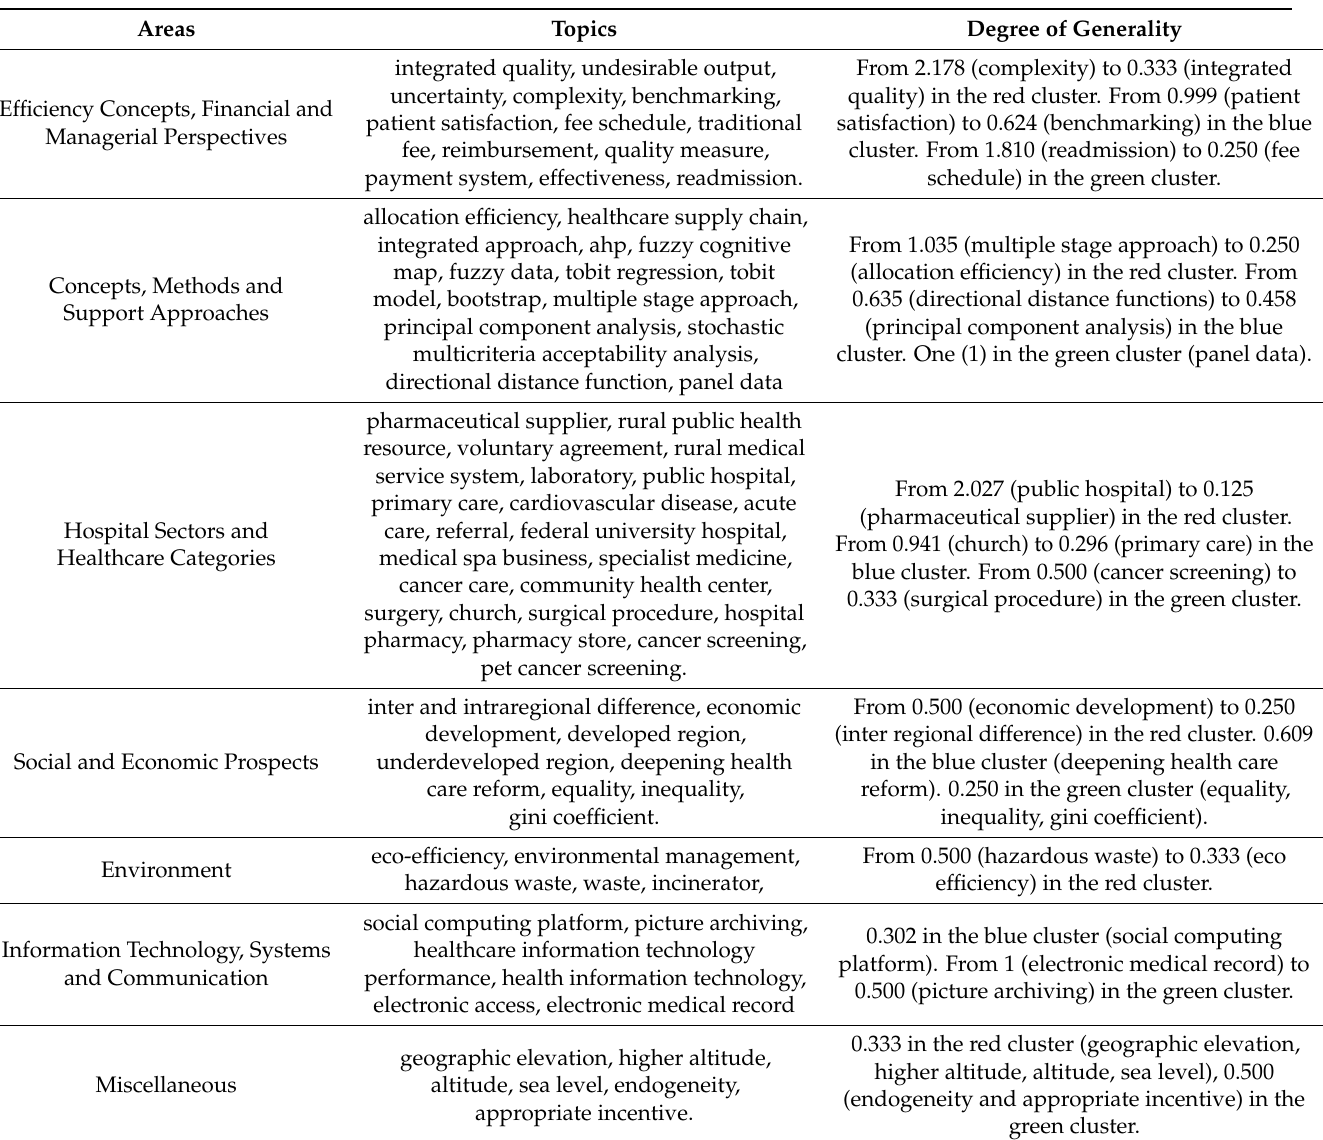
Table 6. Selected Topics and Degree of Generality for a Research